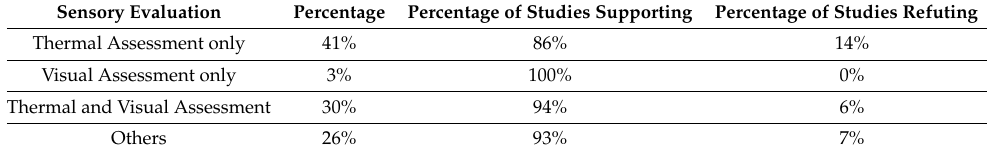
Table 7. Survey and questionnaire